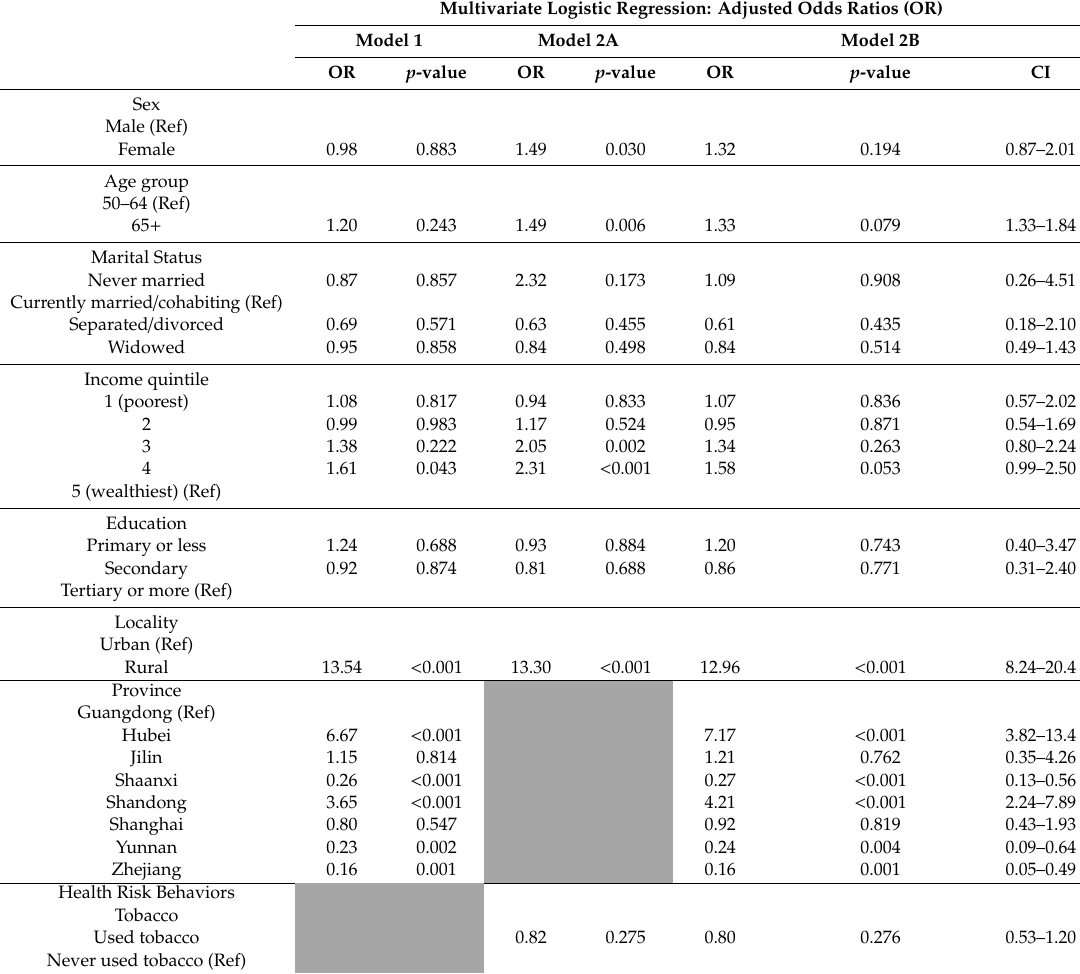
Table 2. Multivariate regression results on the utilization of TCM practitioners, WHO SAGE China (Wave 1). Multivariate Logistic Regression: Adjusted Odds Ratios